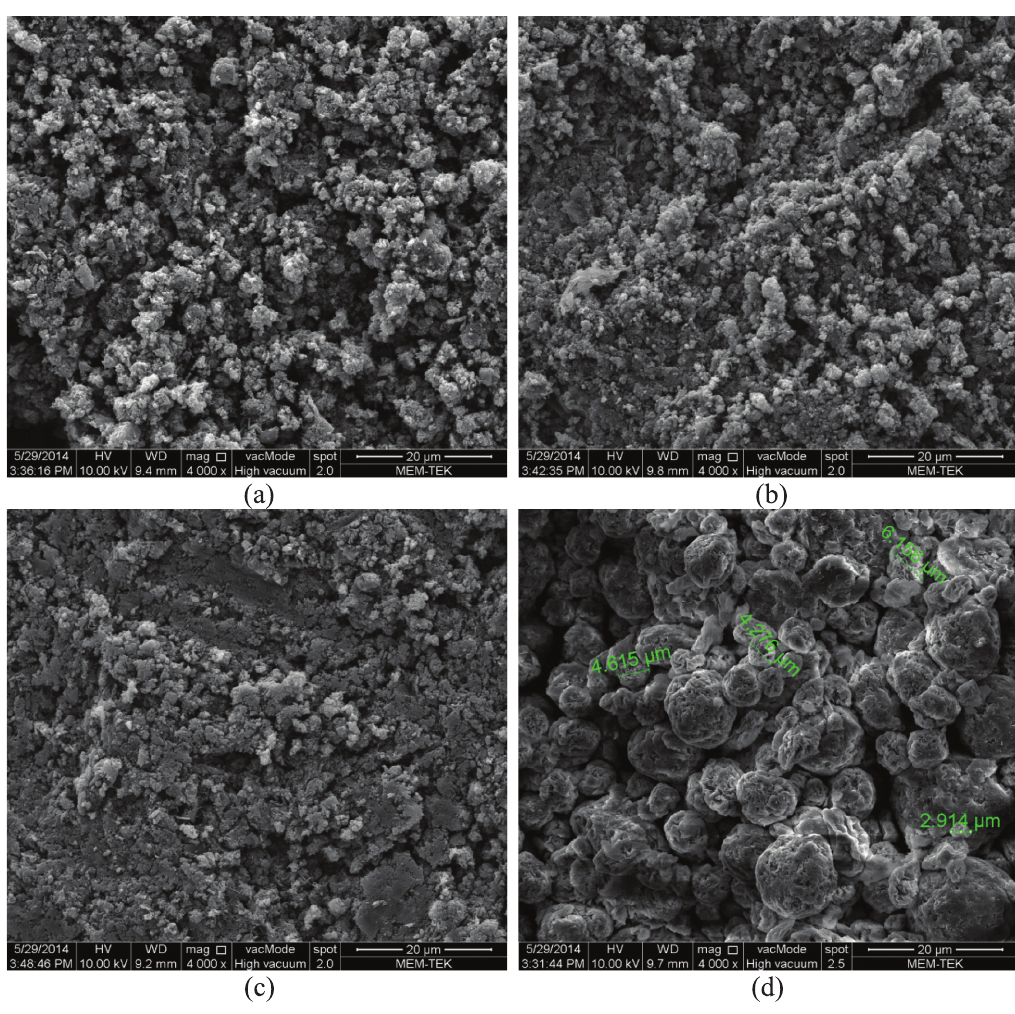
Fig. 3: SEM picture of a) PANI, b) PANI + 5%NC, c) PANI + 10%NC, and d) doped